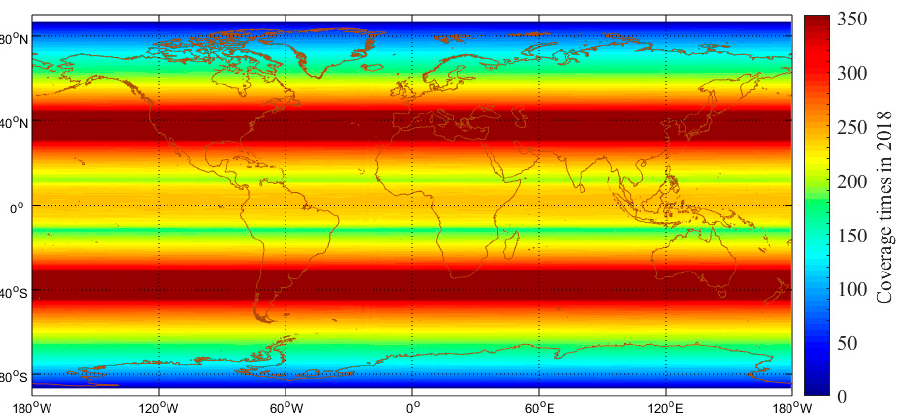
Figure 9. Temporal coverage in 2018 (side-looking, 10–66° incident angle).